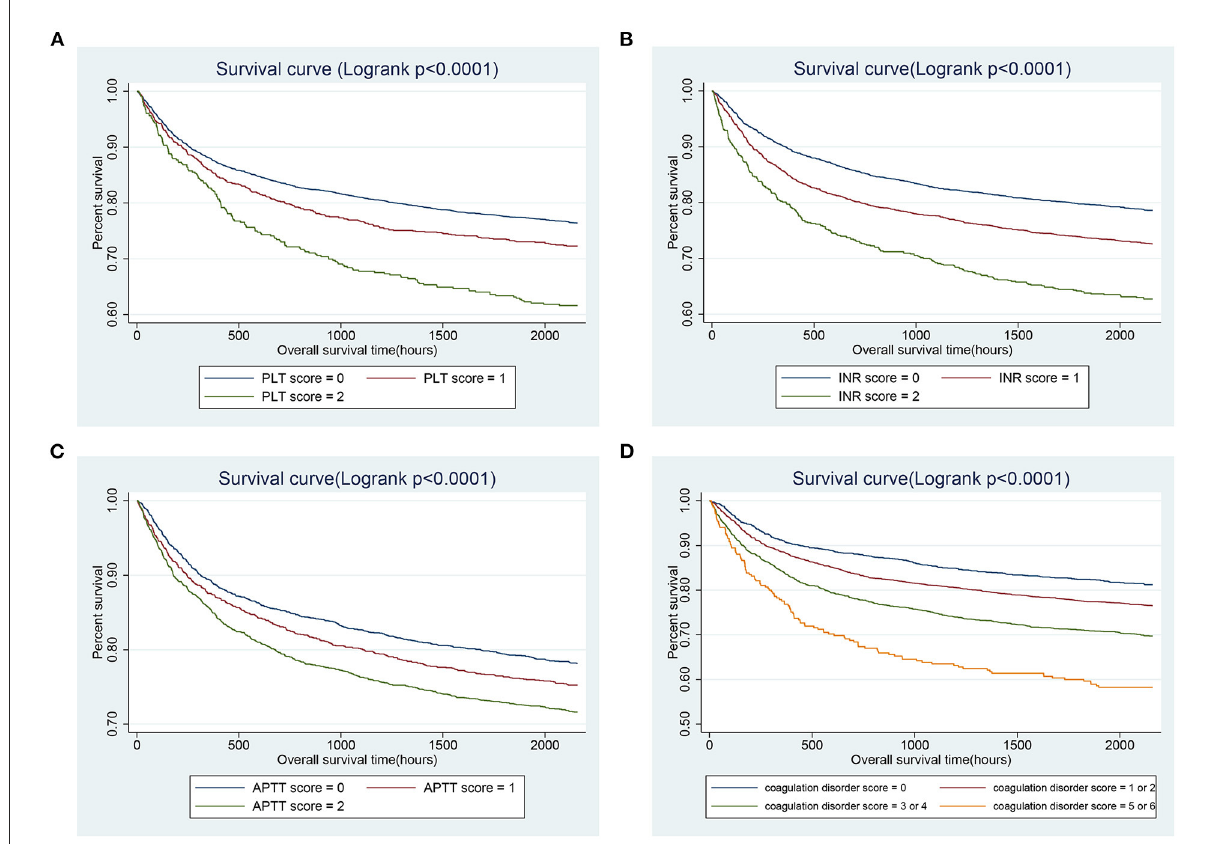
FIGURE2 Kaplan–Meier curves of 90-day all-cause mortality among critically ill patients with CHF stratified by PLT (A) , INR (B) , APTT (C) , and coagulation disorder score (D) . CHF, congestive heart failure; PLT, platelet; INR, international normalized ratio; APTT, activated partial thromboplastin time.